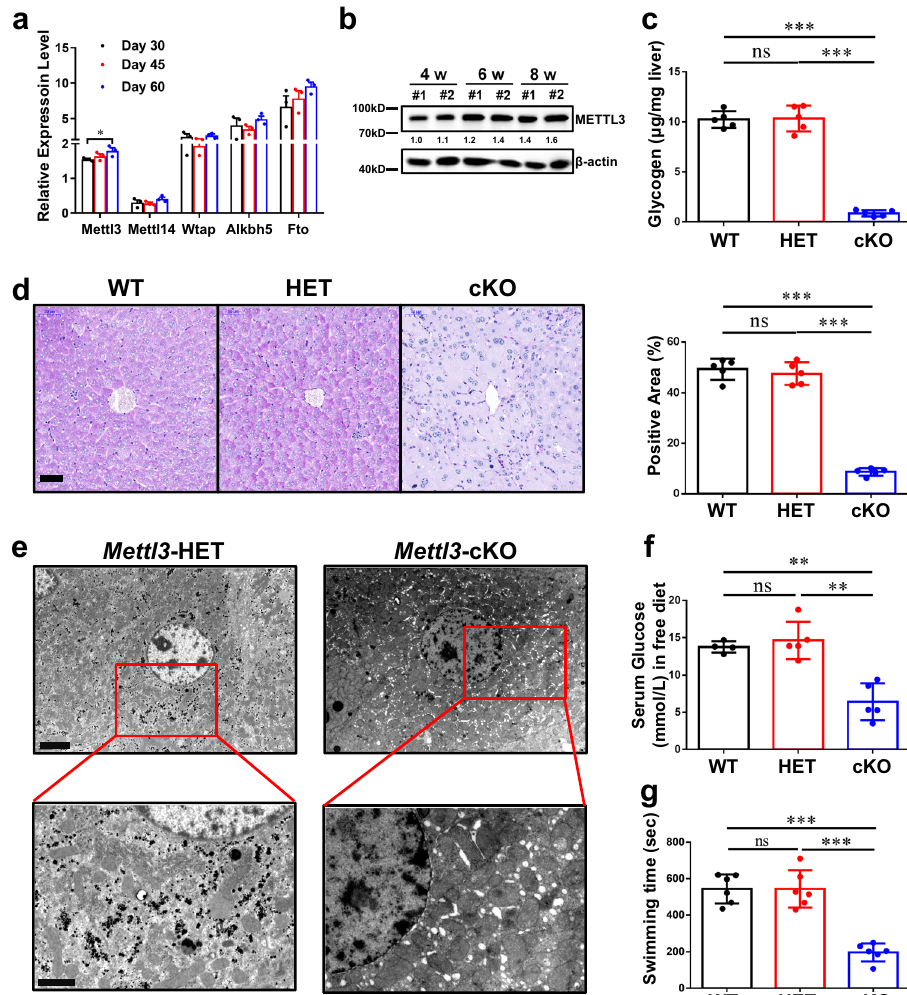
Fig.2| Mettl3 depletionsimulateslackofglycogeninliver.a Relativeexpression levels (FPKM) of fi ve key genes in m6A writing or erasing from a mouse liver- associatedGEOdataset(GSE58827). n =3independentsamples.Dataarepresented asmeanvalues+/ − SEM.Two-wayANOVAwasperformedtodetermineadifference amongcolumnswithinagene.* p <0.05. b Westernblottingassayof Mettl3 protein level in wild-type mouse livers from different ages. This experiment was repeated independently with similar results at least 3 times. c Hepatic glycogen content at different ages, as micrograms per milligram of tissue, n =5 animals. Data are pre- sented as mean values+/ − SEM. One-way ANOVA was performed to determine a differencebetween eachcolumn. ns, not signi fi cant; *** p <0.001. d PASstaining of livers in 8-week-old mice with different Mettl3 genotypes. The percentage of positive area is measured by Image J and shown on the right. WT wild type, HET heterozygous, cKO conditional knockout (Albumin-cre). Bar, 50 μ m. n =5 animals. tool (http://www.cuilab.cn/sramp), and found two candidate sites (Fig. 4d). Then, we built two different “ A to U ” ( “ A to T ” for DNA) mutant constructs of mouse Gys2 CDS (Fig. 4d). Based on the Flag tag in N terminal, we designed speci fi c qPCR primers to detect exogenous mRNA of WT or mutant constructs (Supplementary Table 2). qRT-PCR (Fig. 4e) and Western blot assay (Fig. 4f) in Hepa 1-6 cells showed that +1172, not +2111, is the site that in fl uences expression of Gys2 mRNA. And this conclusion was con fi rmed by dual luciferase report (DLR) assay (Fig. 4g). IGF2BP2-RIP-qPCR illustrated that mutation of +1172 site blocked the binding of IGF2BP2 protein to Gys2 mRNA (Fig. 4h, Supplementary Fig. 4c). Taken together, it depended on an m6A site (+1172 in CDS) that IGF2BP2 combined and stabilized Gys2 mRNA in mouse liver.